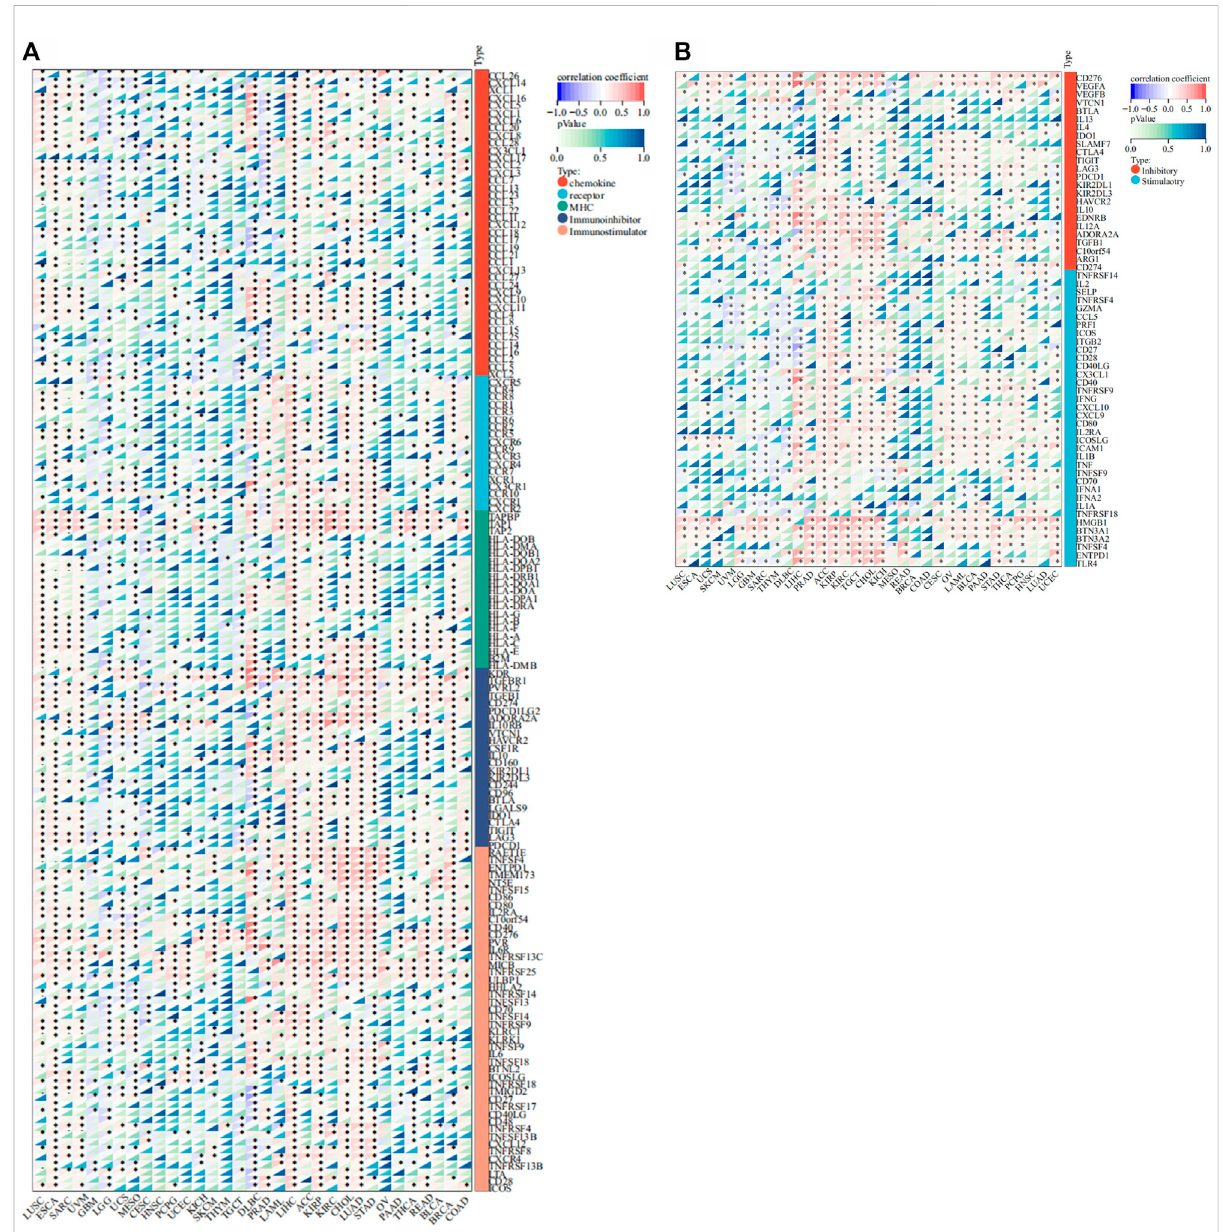
FIGURE 10 Co-expression of FANCE and immune regulated genes. (A) Co-expression of FANCE and 150 immune moderator genes of fi ve immune pathways (chemokine (41), receptor (18), MHC (21), immunoinhibitor (24), immunostimulator (46)) in 33 cancers. (B) Co-expression of FANCE